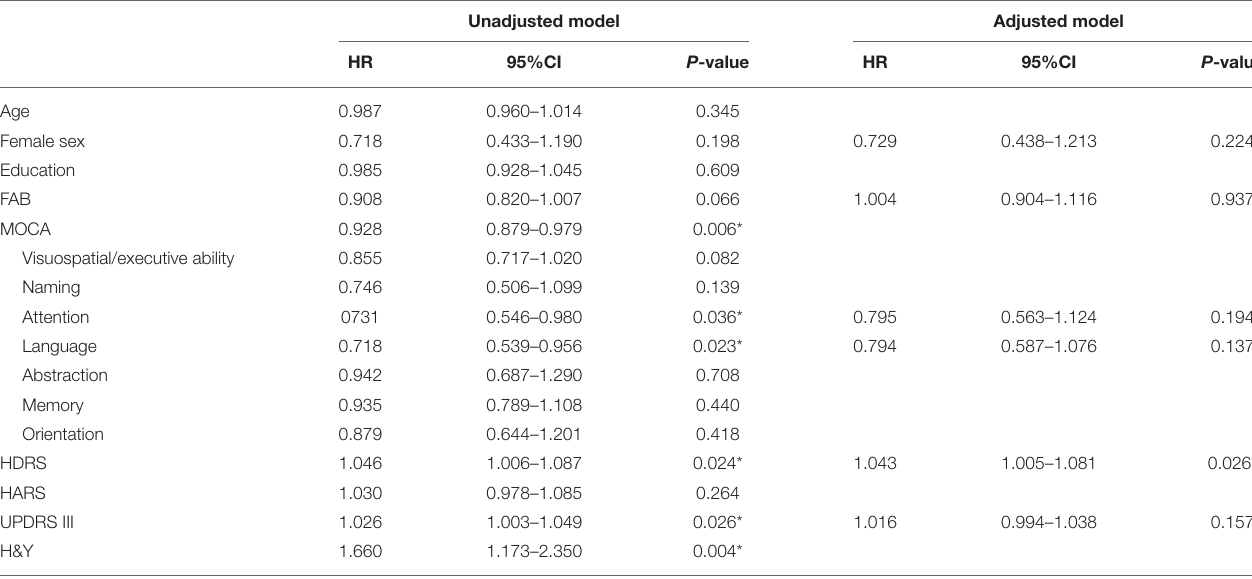
TABLE 3 | Predicted factors for the development of apathy in patients with PD ( n =